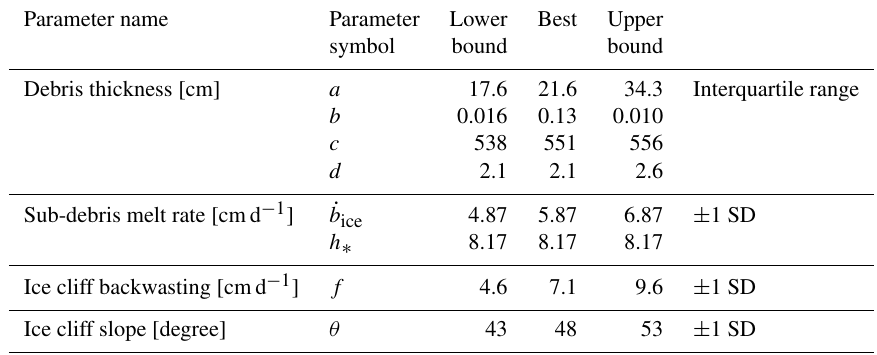
Table 1. Parameters used for the best distributed melt and uncertainty estimates. Parameter name Parameter